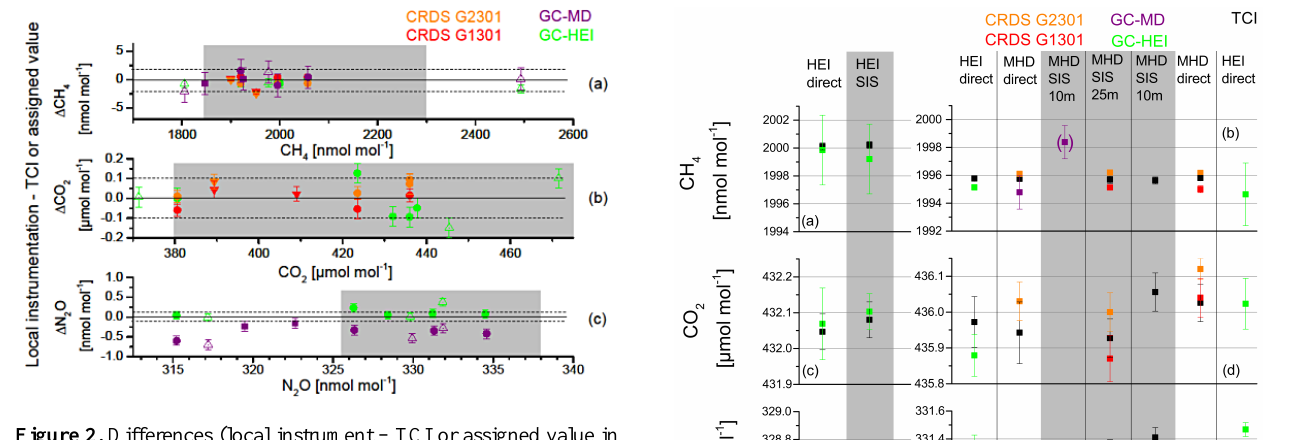
Figure 2. Differences (local instrument – TCI or assigned value in the case of the TCI standards shown as open symbols) of the mea- sured mole fractions of (a) CH 4 , (b) CO 2 and (c) N 2 O of different cylinders: Mace Head AGAGE target cylinders (squares), Heidel- berg target cylinders (circles), TCI working standards calibrated by MPI-BGC GasLab (upward open triangles) and Mace Head CRDS target cylinders (downward triangles). The grey shaded area shows the ambient mole fraction range during the measurement campaign at Mace Head. The direct cylinder measurements at Mace Head were performed partly at the beginning of the campaign (24–26 February 2013) and partly at the end of the campaign (21 May 2013).